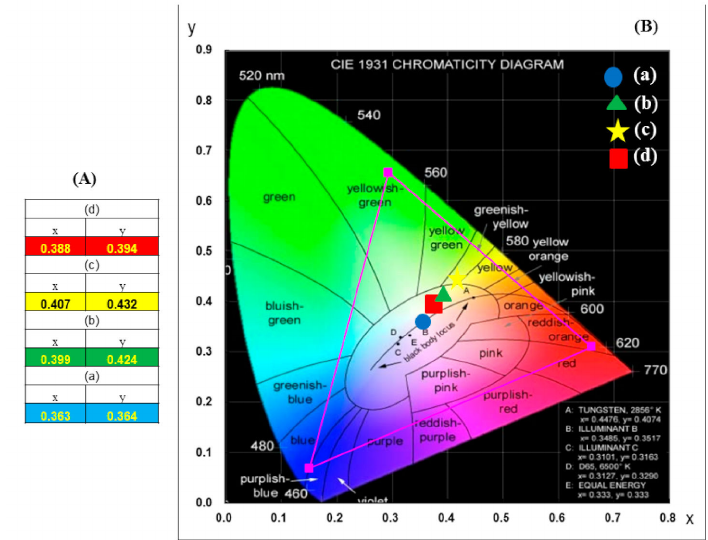
Figure 7. ( A ) Calculated chromaticity coordinates (x, y) values and ( B ) CIE chromaticity diagram for AgGd(MoO 4 ) 2 :Ho 3 + / Yb 3 + phosphors. In the inset are the emission points for the synthesized (a) AgGd 0 (MoO 4 ) 2 , (b) AgGd 0.6 Ho 0.05 Yb 0.35 (MoO4) 2 , (c) AgGd 0.55 Ho 0.05 Yb 0.40 (MoO 4 ) 2